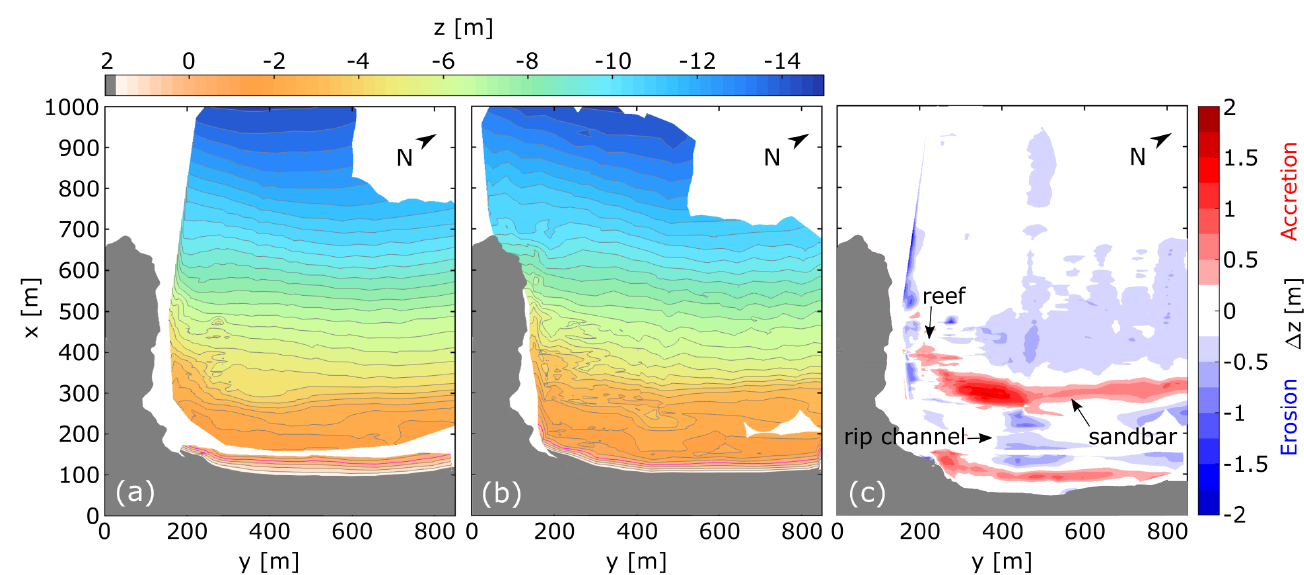
Figure 4. Topo-bathymetric surveys comparison. ( a ) Interpolated bathymetry (5/Oct/2018) and intertidal topography (15/Oct/2018). ( b ) Interpolated bathymetry (26/Oct/2018) and intertidal topography (24/Oct/2018) merged together into a single bathy-topo map. ( c ) Difference between surveys where red colors indicate sand accretion and blue colors sand